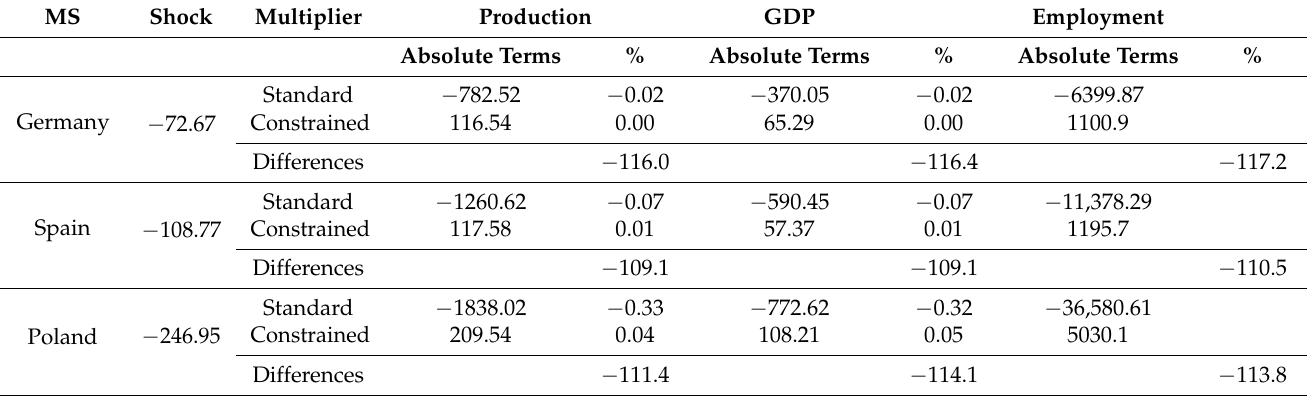
Table 2. Economic impact of FLW reduction by WRS (millions of euros, percentage, number of jobs). MS Shock Multiplier